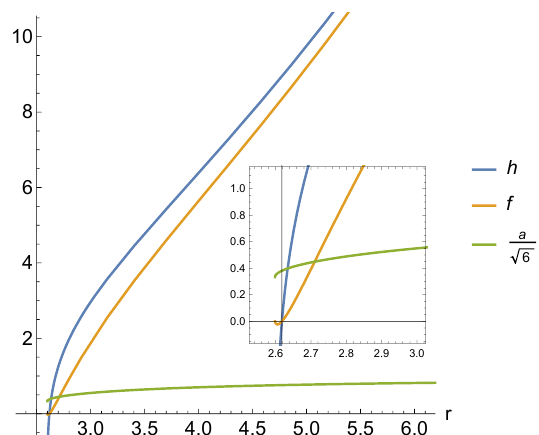
Figure 2 . Black hole solution for M = 0 and non-zero (cid:22) , leading to the AdS asymptotic behaviour. becomes separable